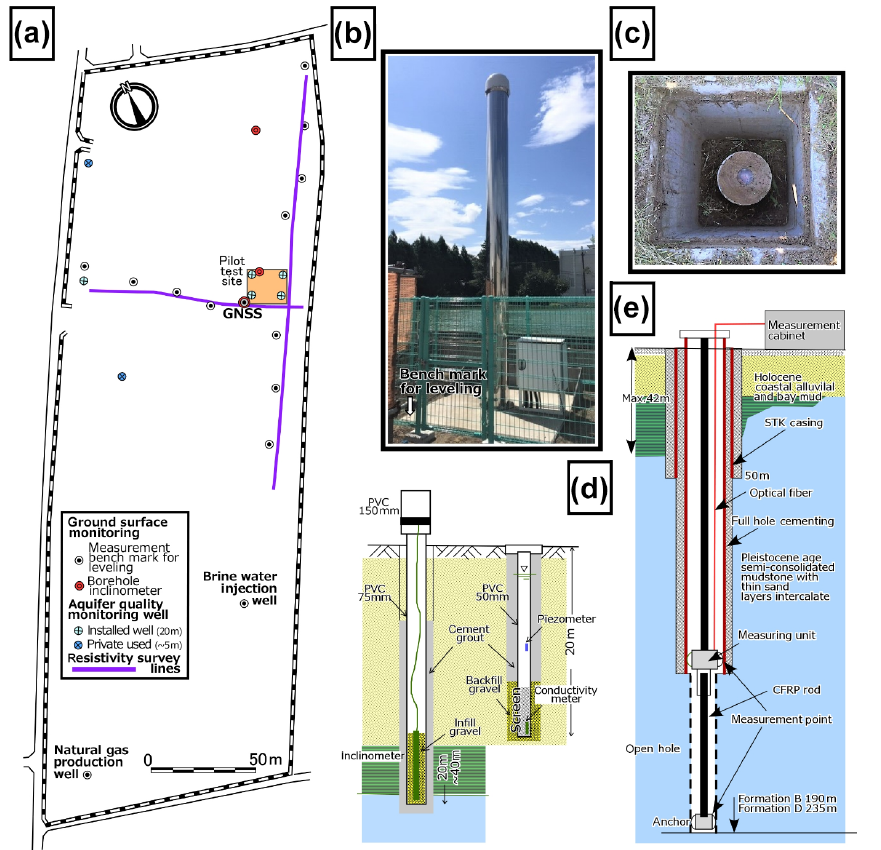
Figure 2. Map showing layout of test site with monitoring items: (a) the detailed site map, (b) GNSS, (c) the bench mark for using sur- face leveling, (d) the installation of inclinometer (left), the groundwater quality and piezometer monitoring well (right), (e) the formation deformation monitoring well and the measured